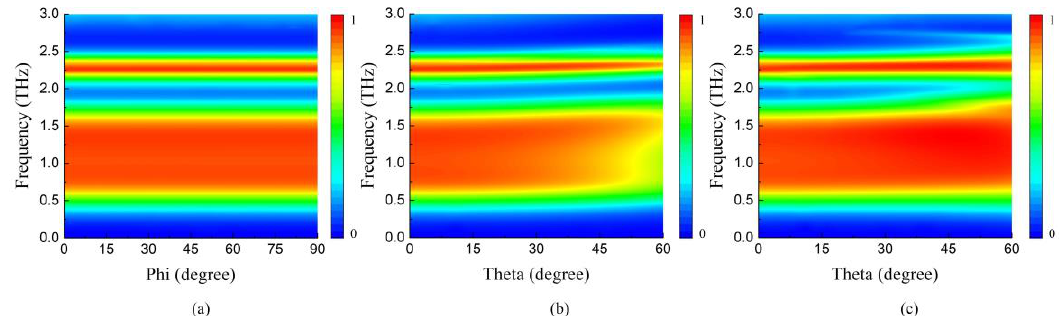
Figure 11. Absorption spectrum of the independently tunable dual-band absorber as a function of frequency and polarization angles / incident angles ( a ) polarization angle φ : 0 ◦ –90 ◦ ; ( b ) TE, incident frequency and polarization angles/incident angles ( a ) polarization angle ϕ : 0°–90°; ( b ) TE, incident angle θ : 0 ◦ –60 ◦ ( c ) TM, incident angle θ : 0 ◦ –60 ◦ angle θ : 0°–60° ( c ) TM, incident angle θ : 0°–60°.